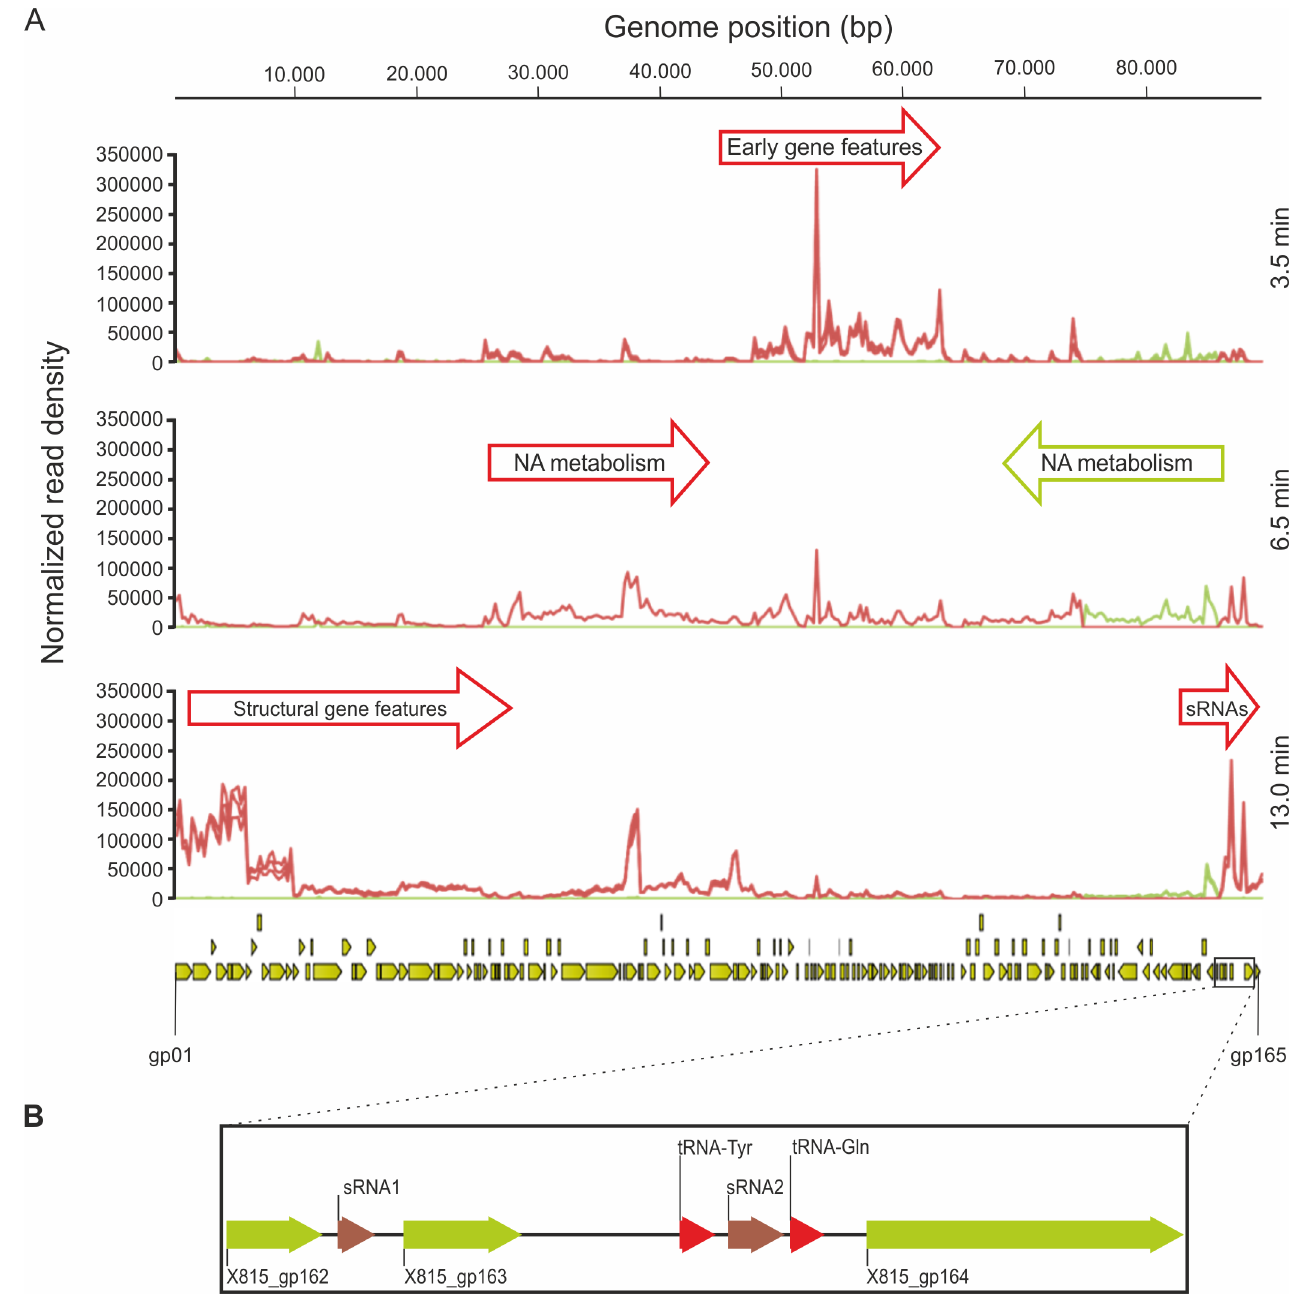
Fig 7. PAK_P3 transcription is temporally regulated. (A) Mapped reads were summarized into stranded count tables of Total Gene Reads that align to every 250bp of the PAK_P3 genome using the CLC Genomics Workbench. These read counts were then normalized against each other by the Total Count of reads that align to both phage and host genomes for each sample and then plotted. This allows us to show the relative abundance of phage transcripts over time in the context of the total transcript population. Red and green graphs represent reads mapping to the forward and reverse strands, respectively, for each replicate in each condition. The PAK_P3 genome is represented at the bottom of the panel with yellow arrows indicating defined coding sequences. (B) Enlargement of the PAK_P3 genome region encoding small RNAs. NA = nucleic acid